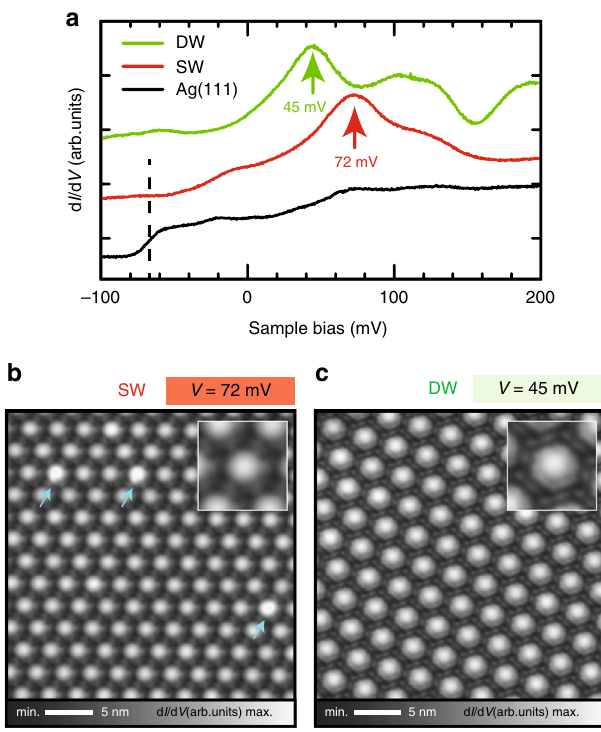
Fig. 2 Local electronic structure of the SW and DW networks. a Conductance (d I /d V ) spectra on the pristine Ag(111) ( black ), on the pore centers of the SW network ( red ) and DW network ( green ). b , c d I /d V maps on the SW and DW networks acquired on the peak maxima in a , enlarged in the corresponding insets. Measurement parameters: I = 10 pA, V = 72 mV, modulation voltage V ac = 10 mV, oscillation frequency f ac = 513 Hz ( b